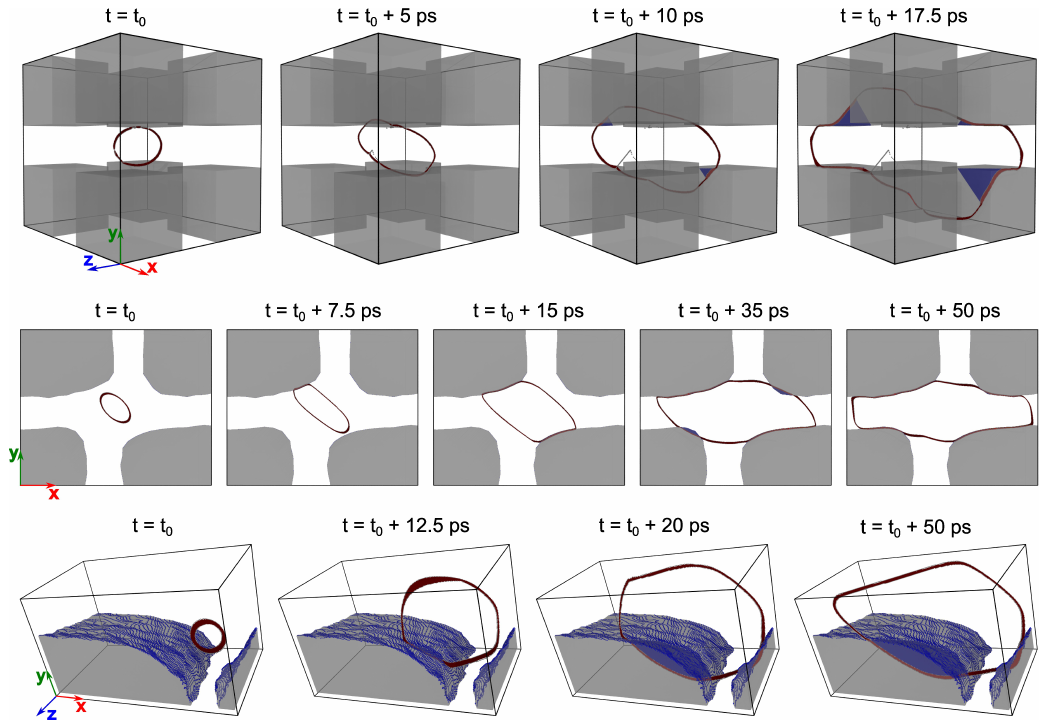
Figure 5. Evolution of a dislocation loop in the different atomistic samples. Top row: sample S cub (Cube sample); Central row: SEM micrograph informed sample S 2 DSEM . Bottom row: APT-informed sample S APT , stoi with the stoichiometric chemical composition. The γ (cid:48) particle is enclosed by a semi-transparent surface. For clarity, only atoms identified as defects are shown. In samples S cub and S APT , stoi , with fully-3D boundary conditions, the dislocation loop cuts through the γ (cid:48) precipitate. By contrast, in sample S 2 DSEM (with quasi-2D BC), only deposition of the loop is observed. Evolution of the loop in sample S 2 Dp shows the same characteristics as that of sample S 2 DSEM and is hence not shown here for the sake of brevity. Likewise, since the loop collapses even under applied strain in sample S APT , non − stoi (APT-informed non-stoichiometric sample), the evolution of the loop is also not shown. The color code denotes defects as identified by AtomViewer [43,44]: red, stacking fault (lighter shade used to denote complex stacking fault in γ (cid:48) phase); blue, antiphase boundary; white, other